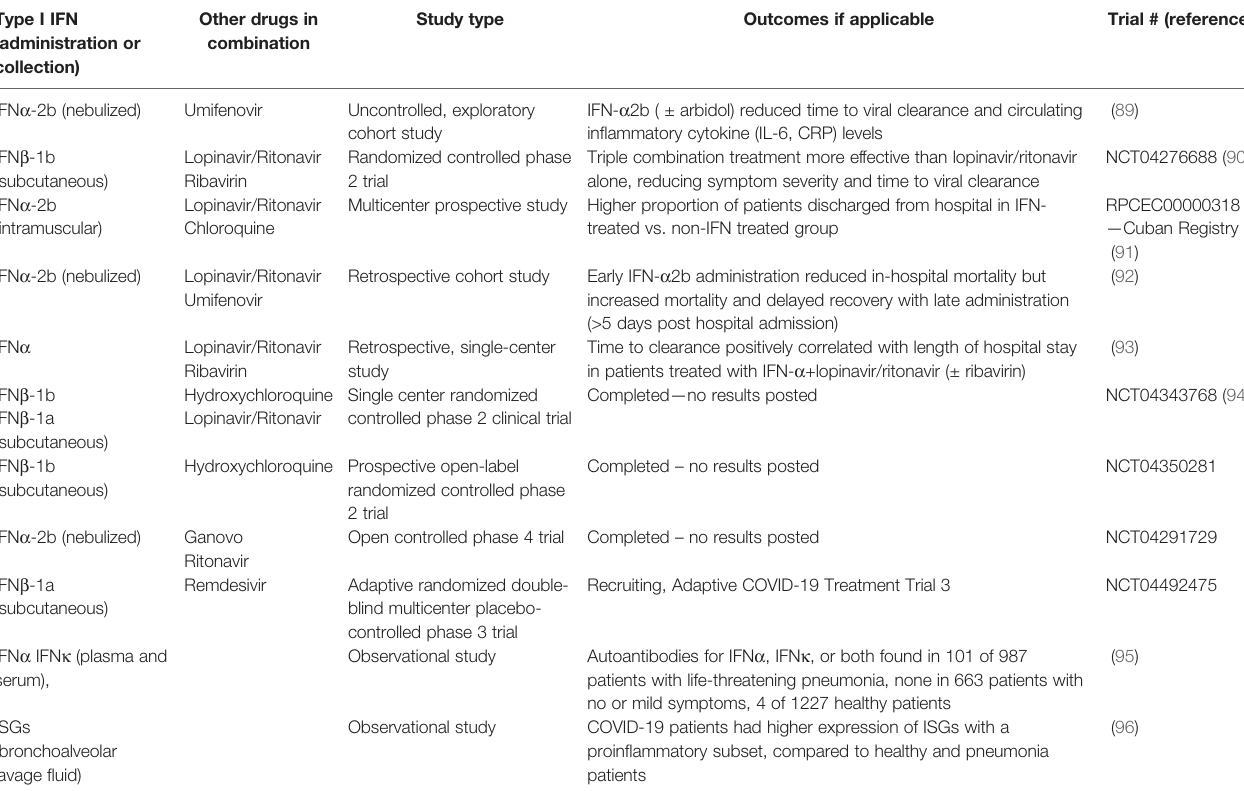
TABLE 2 | Clinical studies involving type I interferons in